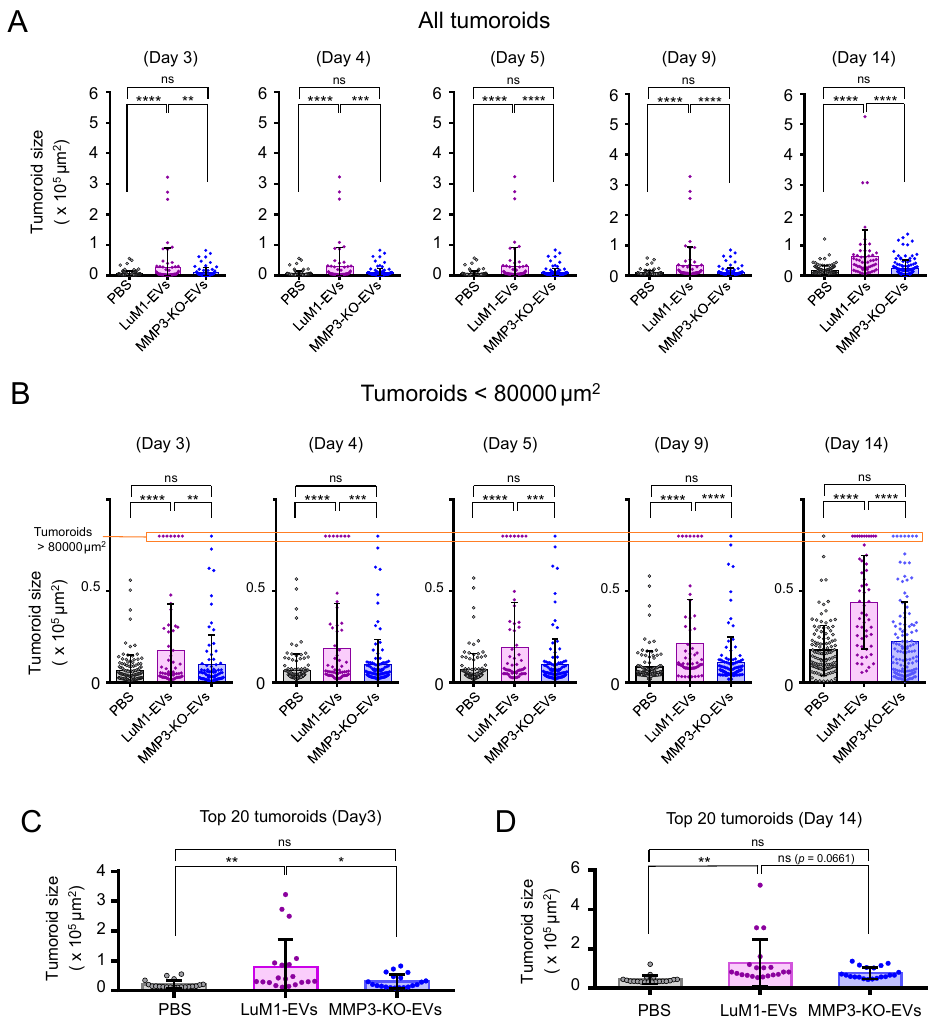
Figure 6. Tumoroid size altered by the addition of LuM1-EVs versus MMP3-KO-EVs. ( A , B ) Tumoroid size quantification of ( A ) all tumoroids and ( B ) tumoroids smaller than 80,000 µ m 2 at the indicated time points of the tumoroid formation. Cell aggregates ( > 500 µ m 2 ) were considered as tumoroids. ( B ) Tumoroids larger than 80,000 µ m 2 were shown on the top of the graph. ( C , D ) Top 20 tumoroids size quantification on ( C ) day 3 and ( D ) day 14. * p < 0.05, ** p < 0.01, *** p < 0.001, **** p < 0.0001; ns, not significant; n = 54–130 (number of plots). The experiments were repeated twice.